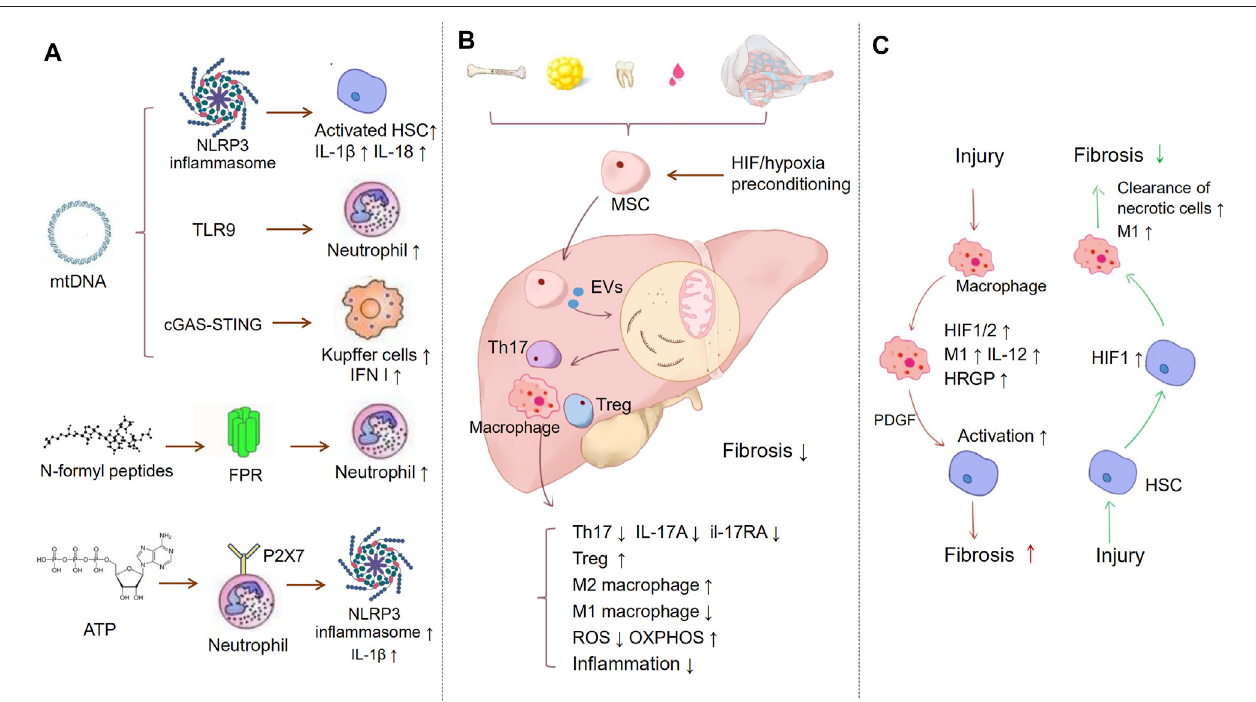
FIGURE 2 | Immune regulation in liver fi brosis. (A) In fl ammation is a major process in the development of fi brosis. MtDAMPs, including mtDNA, N-formyl peptides, and ATP, are released to extracellular space in the case of ROS-driven mitochondrial membrane permeability transition. MtDNA can activate NLRP3 in fl ammasomes, TLR9, and cGAS-STING, which separately induce HSCs, neutrophil, and KCs activation. NFPs are released from dysfunctional mitochondrial, binding to FPRs, which leads to the migration of neutrophil cells to the injury tissue. Released ATP binds to P2X7 receptors on neutrophils, inducing NLRP3-ASC-caspase-1 in fl ammasome andIL-1 β secretion. (B) MSCsactasabridgetopreventin fl ammation andoxidativestress via extracellularvesicles,etc. MSCssuppress theproliferation ofTh17cellsanddecrease theexpression ofIL-17Aandil-17RA.Meanwhile,MSCspromotetheactivationofM2macrophagesandinhibitM1macrophagesactivation, hypoxia-preconditioning,and HIF-1overexpressioncanimproveMSC therapeutic. (C) HIFmayplay different rolesindifferentcells. Thechronic liverinjuryactivates HIF- 1 α inmacrophages,whichmayregulatetheexpressionofPDGF-BtoinduceHSCsactivationand fi brosis.However,livernecroticcellscanalsoactivateHIF-1 α inHSCs. HIF-1 α then stimulated recruited macrophages to remove necrotic hepatocytes and alleviate fi